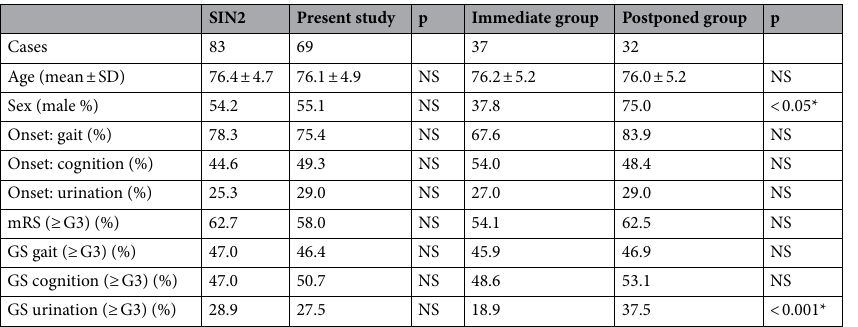
Table1. Clinical characteristics of patients. G grade, GS iNPH grading scale, NS statistically not significant, p probability, SD standard deviation. *Statistically significant.